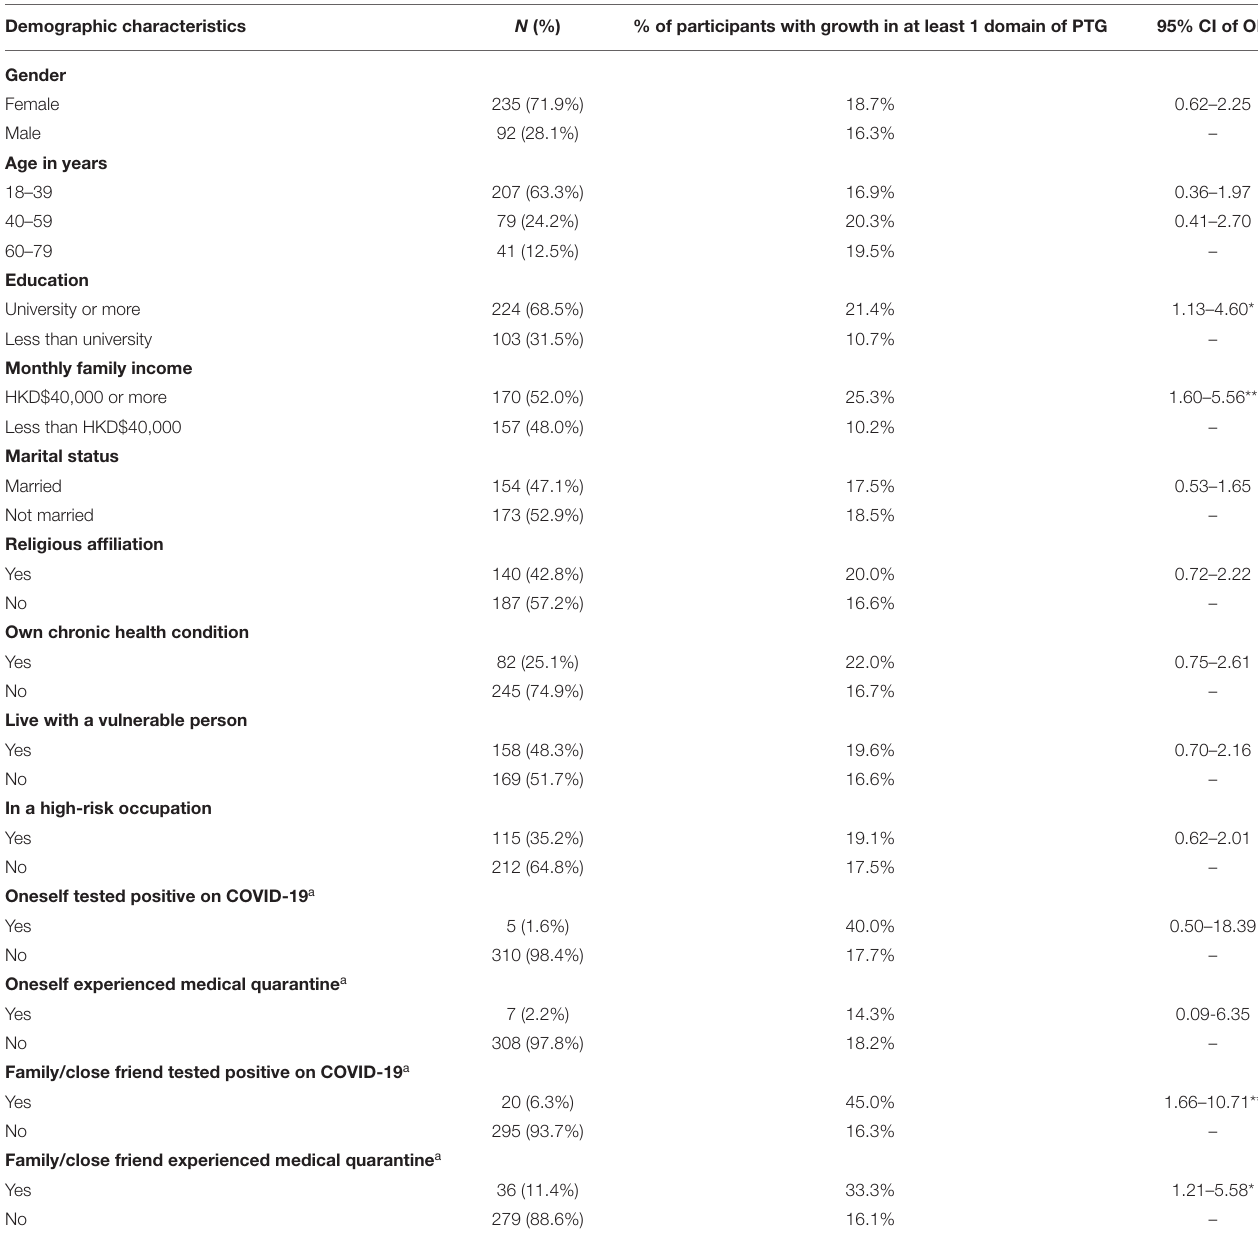
TABLE 1 | Post-traumatic growth by demographic characteristics ( N = 327). Demographic